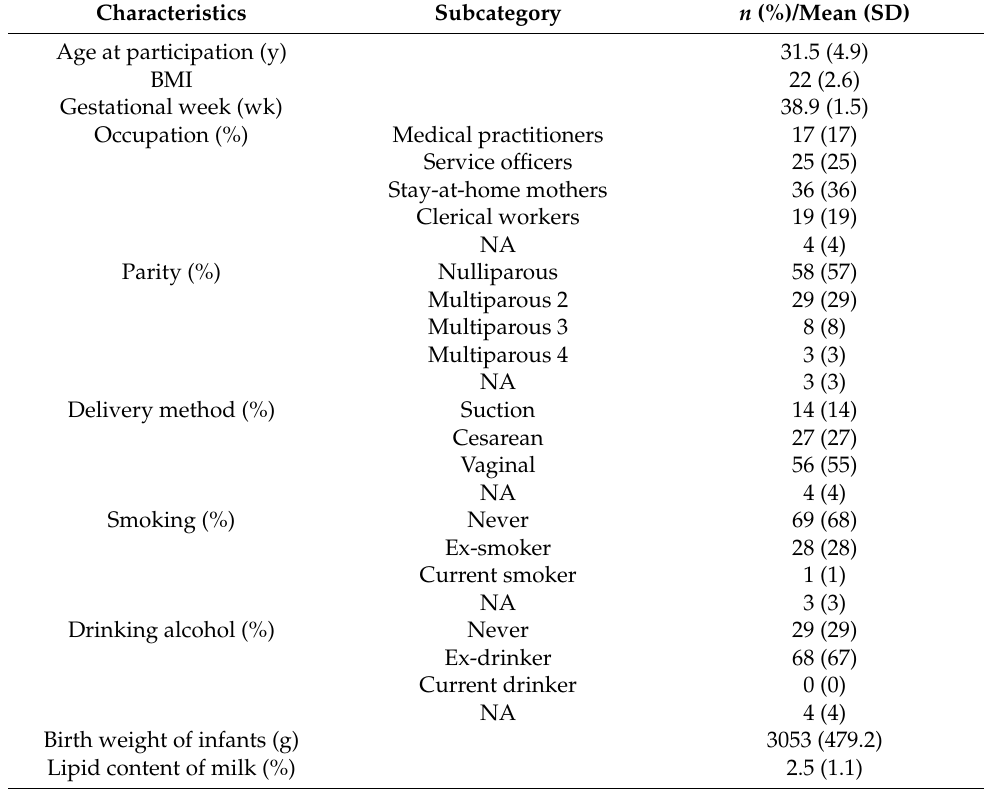
Table 1. Characteristics of study participants ( n =